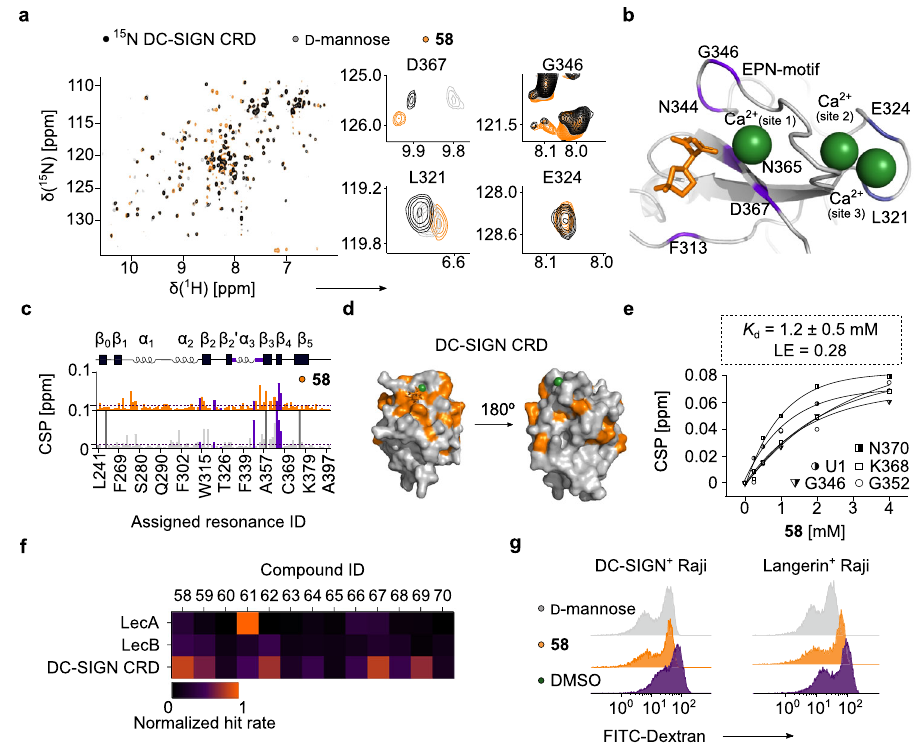
Fig. 4 Malonates as inhibitors of DC-SIGN (CD209). a Protein fi ngerprint of 15 N DC-SIGN CRD in 15 N HSQC NMR alone ( black ) and with 2mM 58 ( orange ) or 30mM D-mannose ( gray ). Similar to D-mannose, 58 perturbed the resonances D367, G346 and L321, but not E324 being in the Ca 2 + (site 1) and Ca 2 + (site 1)/Ca 2 + (site 3)-binding sites, respectively. These residues are highlighted in ( b ), which shows a docked 58 in the Ca 2 + site 1 of DC-SIGN CRD (PDB: 2XR5). c Quantitative analysis of chemical shift perturbation (CSP) of 15 N DC-SIGN CRD in the presence of 58 and D-mannose. Resonances D367, G346, L321 and E324 are highlighted ( violet ). A schematic representation of DC-SIGN CRD is shown on top. Malonates perturbed resonances similarly to D-mannose, i.e. in the long loop locating the EPN motif ( violet ). d The CSPs promoted in 15 N DC-SIGN CRD by 58 were transferred to DC-SIGN CRD (PDB: 2XR5). e One-site binding model of 58 to DC-SIGN CRD derived by following CSPs of the resonances perturbed in the long loop and β 4 sheet. f Heat map shows the 1:0 hit rate of 58 analogs for LecA, LecB and DC-SIGN normalized to the effect of MeGal, MeFuc and D-mannose, respectively. g Shown are fl ow cytometry histograms of DC- SIGN + and Langerin + Raji cells bound to FITC-dextran in the presence of DMSO or D-mannose used as a negative and positive controls in a cell-based (cellFy) assay, respectively. 58 inhibited FITC-dextran binding to DC-SIGN similarly to D-mannose, but not to